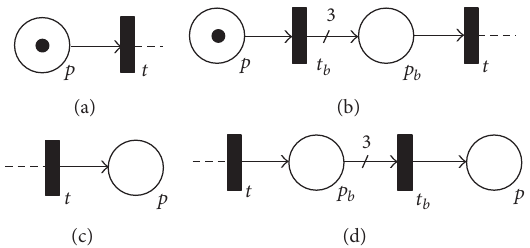
Figure 4: (a) A Petri net, (b) a three-derivation process, (c) a Petri net, and (d) a three-convergence process.